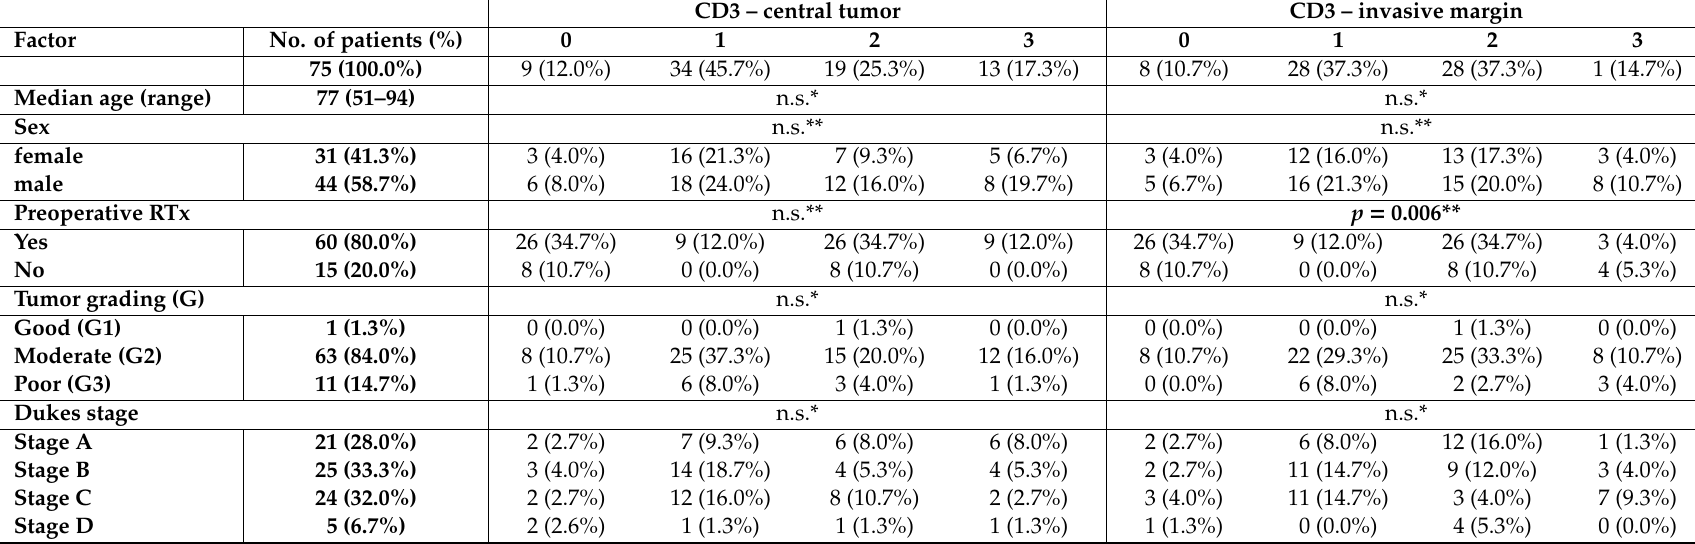
Table 1. Patient and tumor characteristics in relation to the level of CD3 T cell expression determined analogously on full tissue sections. CD3 – central tumor CD3 – invasive